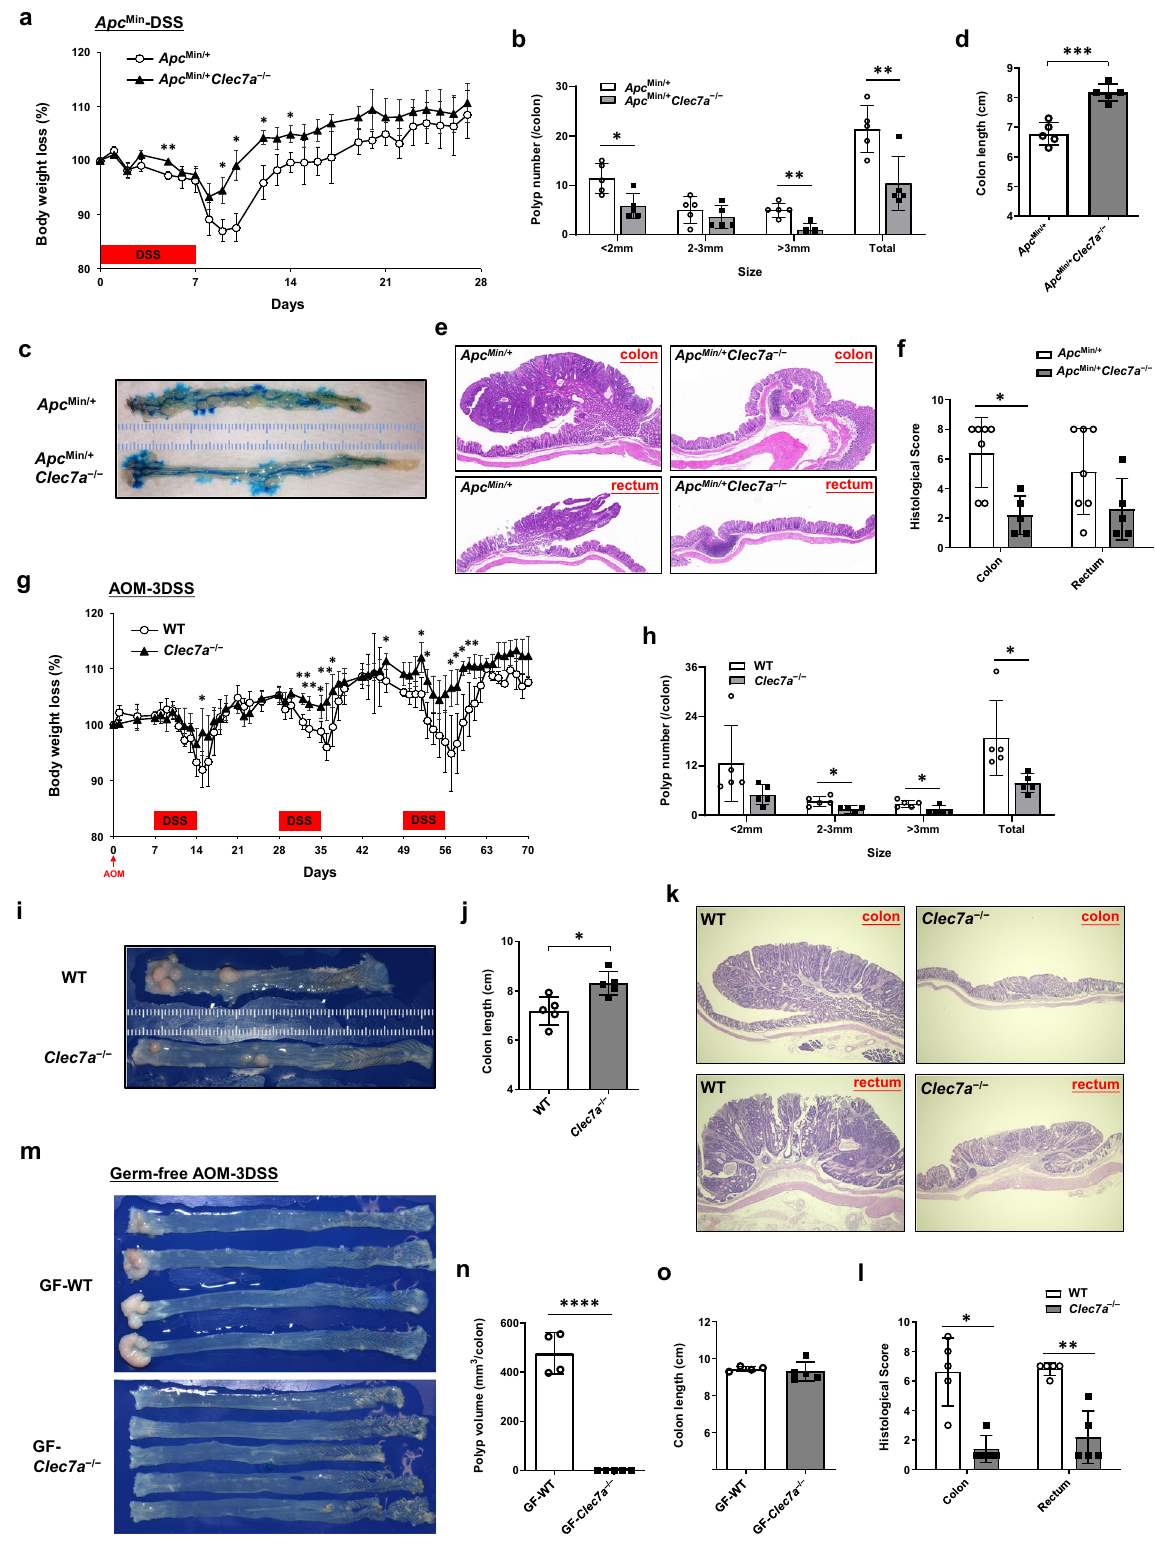
Fig. 1r, s), consistent with the suppression of tumor growth in Clec7a − / −